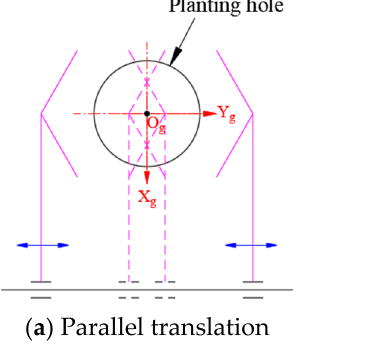
Figure 7. Clamping motion pattern of the two V-shaped fingers: ( a ) the parallel translation mode, ( b ) the single-pivot rotation mode, and ( c ) the double-pivot rotation mode.